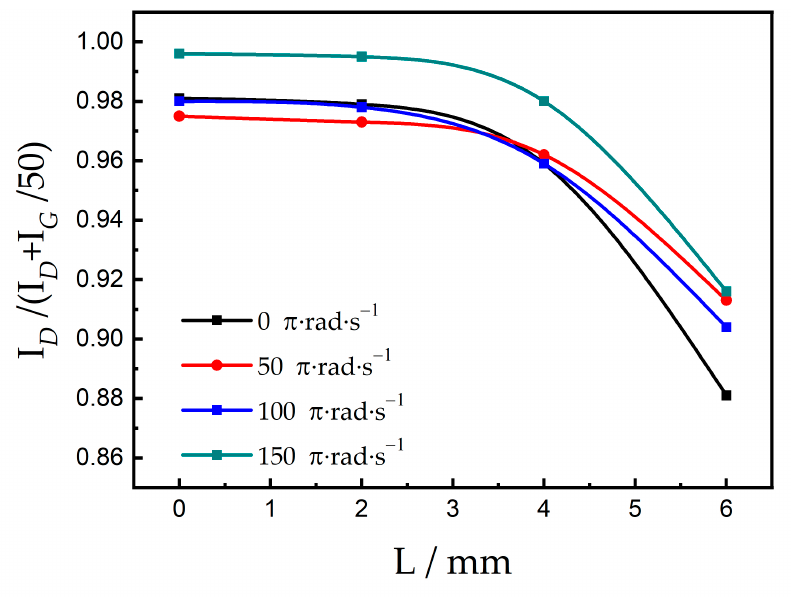
Figure 8. CVD diamond quality of a large area diamond film along the L direction under a dynamic magnetic field with different angular frequencies.